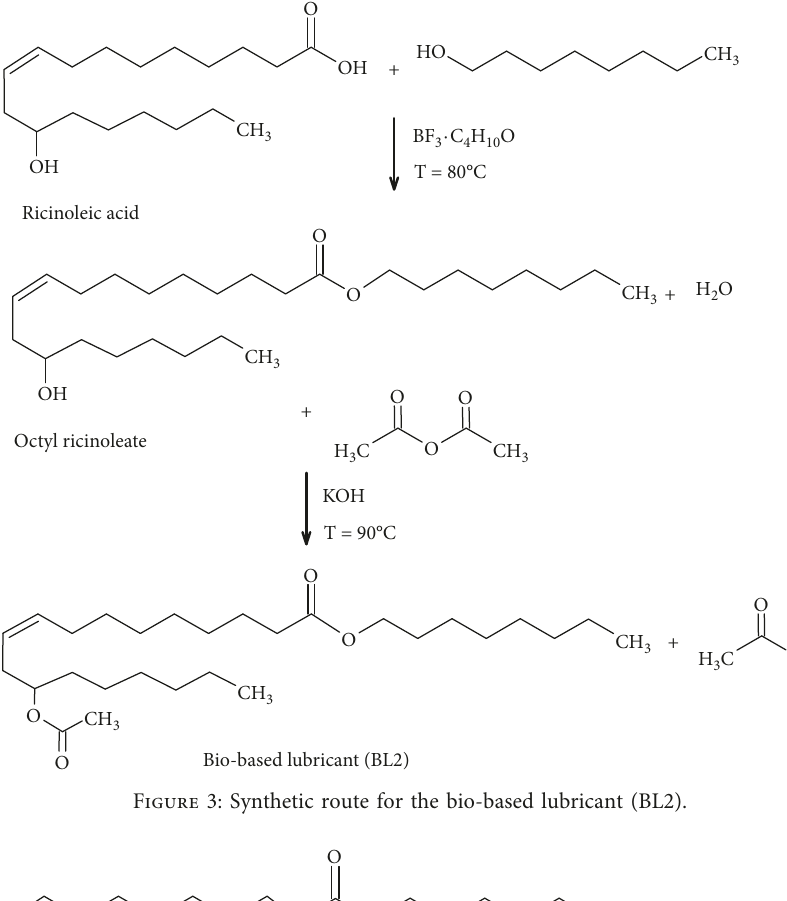
Figure 3: Synthetic route for the bio-based lubricant (BL2).